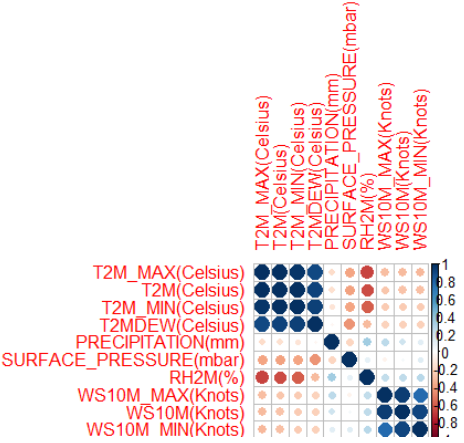
Figure 5. Correlations of predicted numeric attributes.